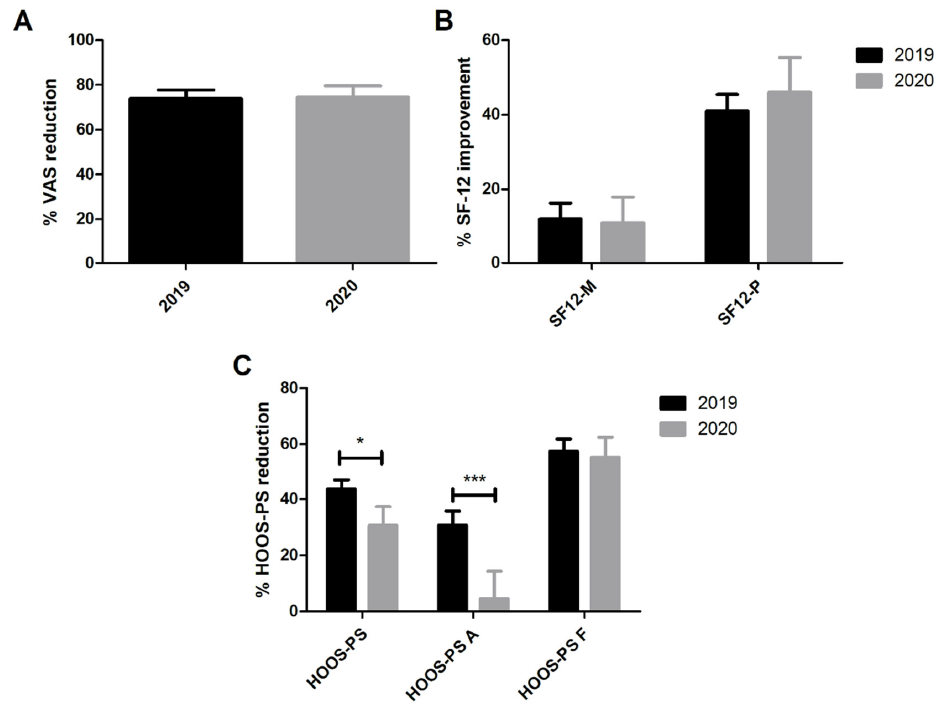
Figure 2. VAS ( A ), SF-12 ( B ) and HOOS-PS ( C ) percentage improvements in patients treated for THA in 2019 and 2020. * p < 0.05, *** p < 0.001. Data expressed as mean ± SEM. Table 2. PROMs in THA patients.